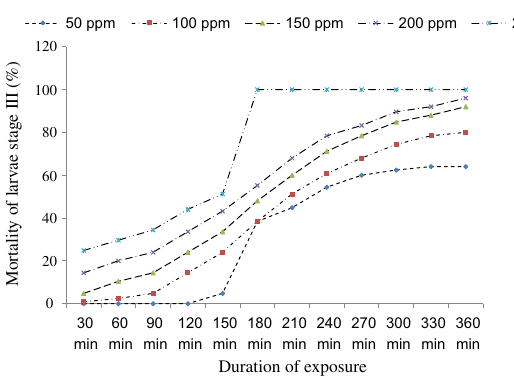
Figure 1. Percentage of mortality of stage III larvae of Anopheles funestus s.s. depending on the duration of exposure to different concentrations of the essential oil of Cymbopogon citratus .